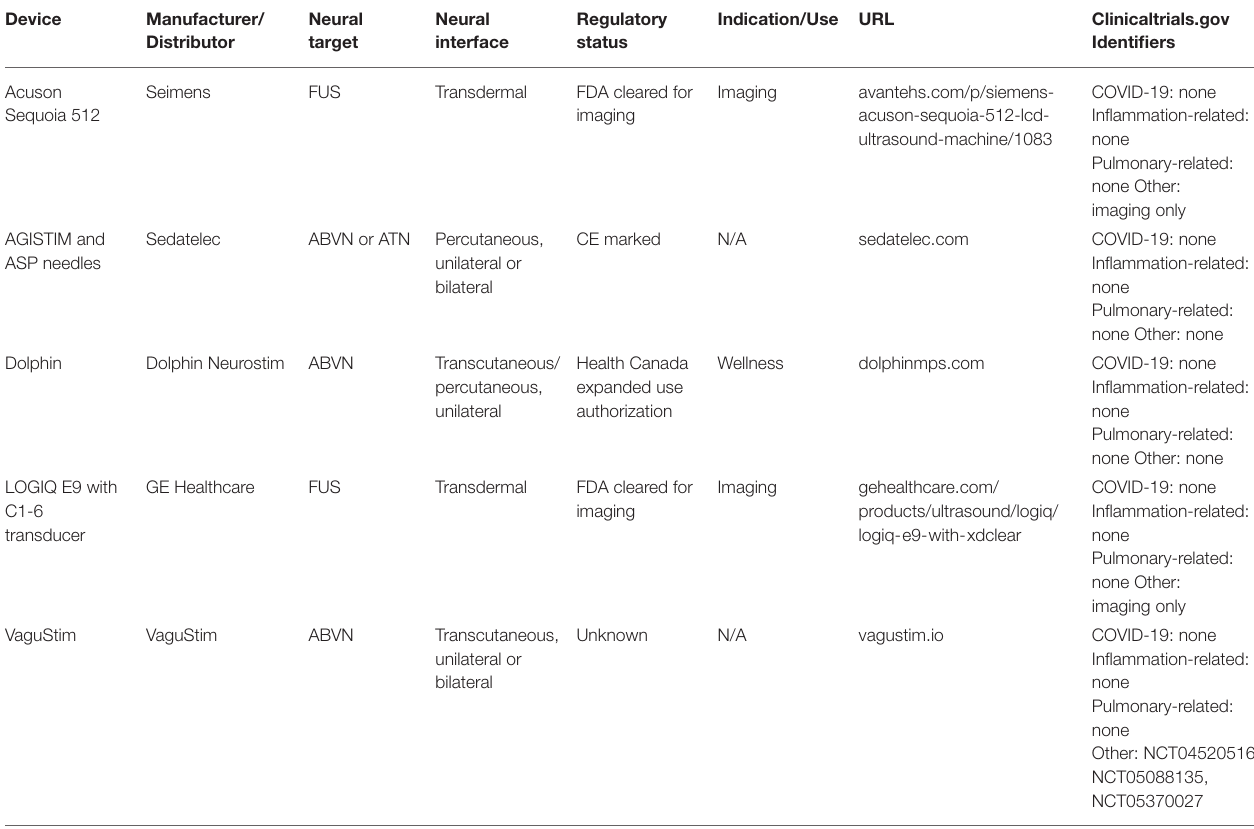
TABLE 4 | Examples of devices with neural mechanisms that may be related to modulating the pathological sequelae of COVID-19, but which have not yet been assessed for relevant endpoints.